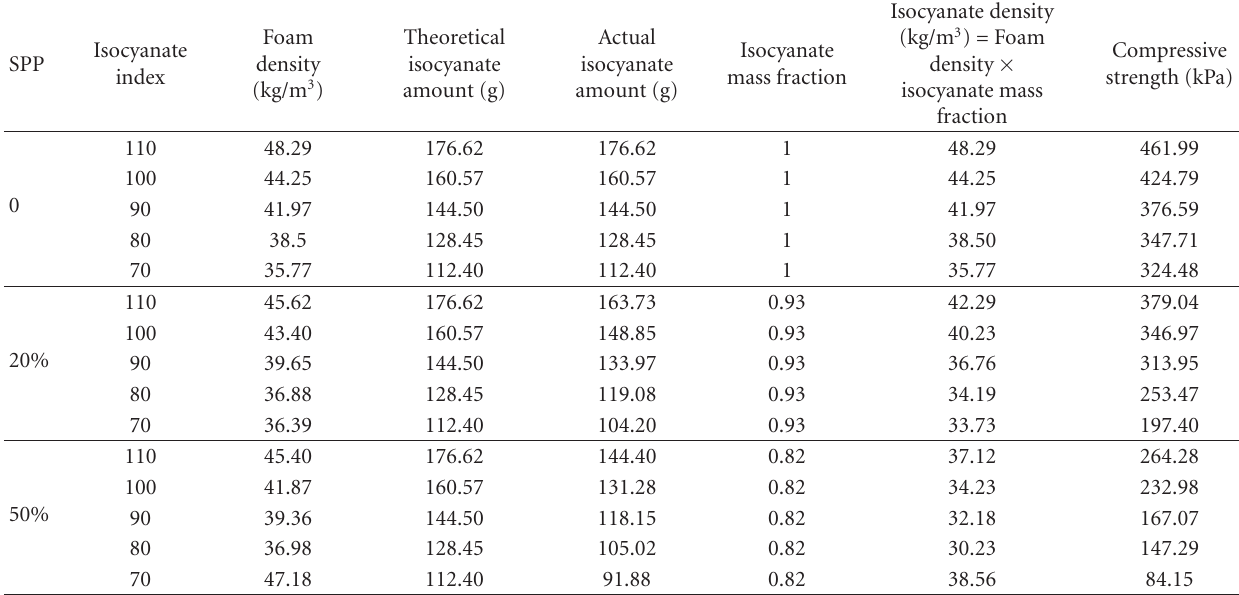
Table 6: Calculation of isocyanate